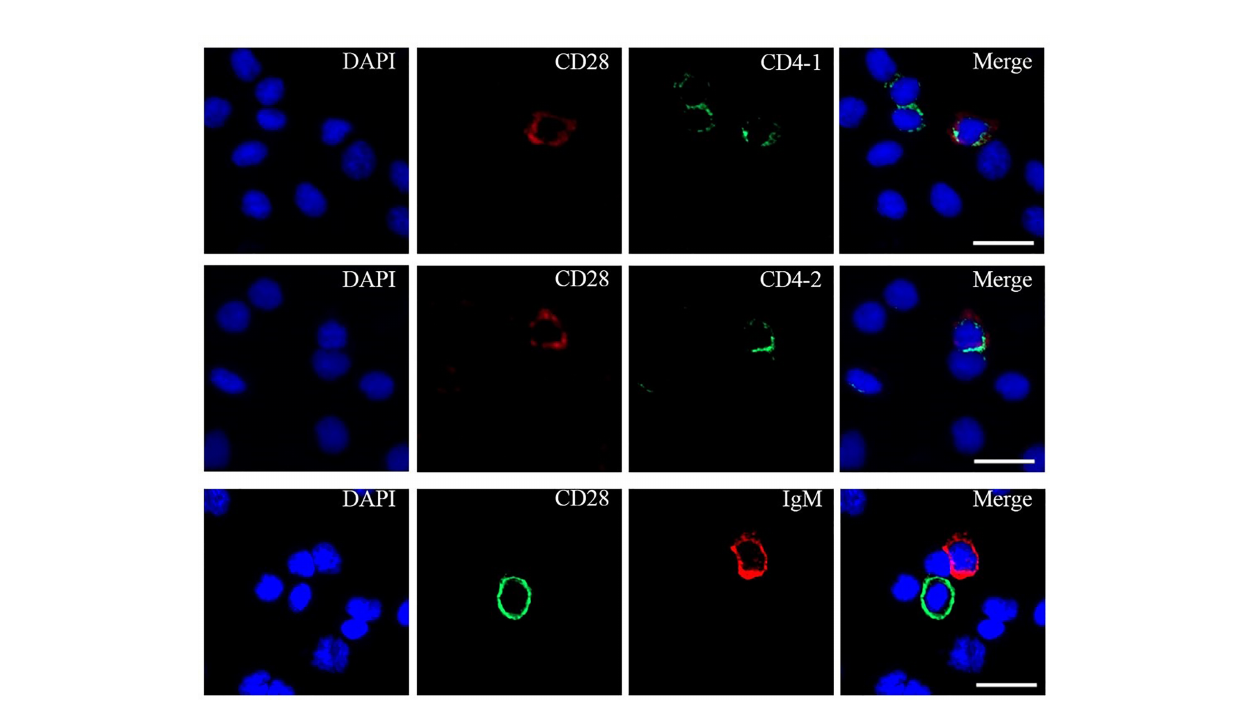
FIGURE 4 | Co-localizations of CD28 with CD4-1, CD4-2, or IgM in PBLs. The leukocytes were incubated with primary Abs rabbit-anti CD28 with mouse-anti IgM, mouse-anti CD4-1, or mouse-anti CD4-2, respectively. DAPI staining shows the location of the nucleus. The unimmunized serum was used as negative control (data not shown). Scale bar = 10 m